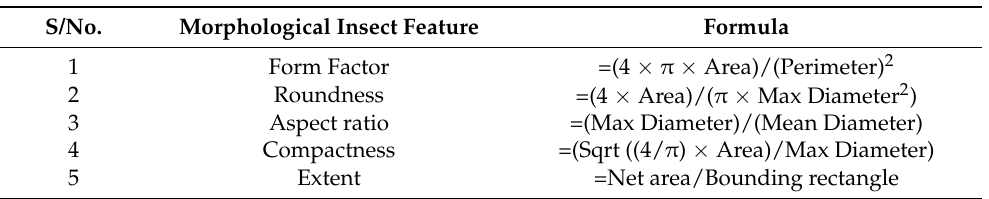
Table 1. Essential techniques for the evaluation of morphological variations between insect species during feature classifications. S/No. Morphological Insect Feature